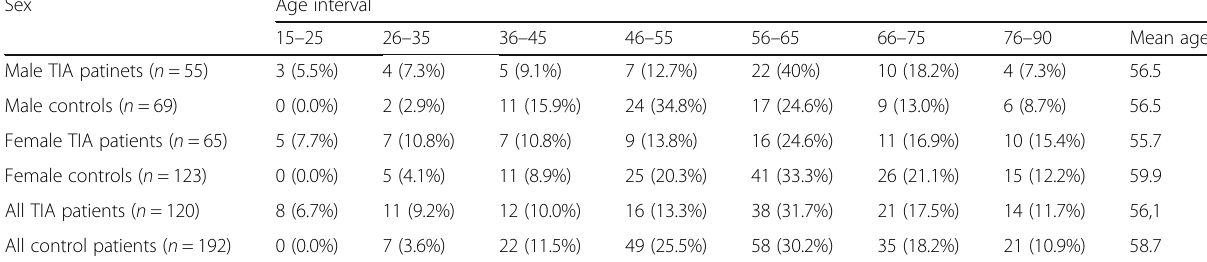
Table 1 Distribution of patients with TIA and controls by age and sex